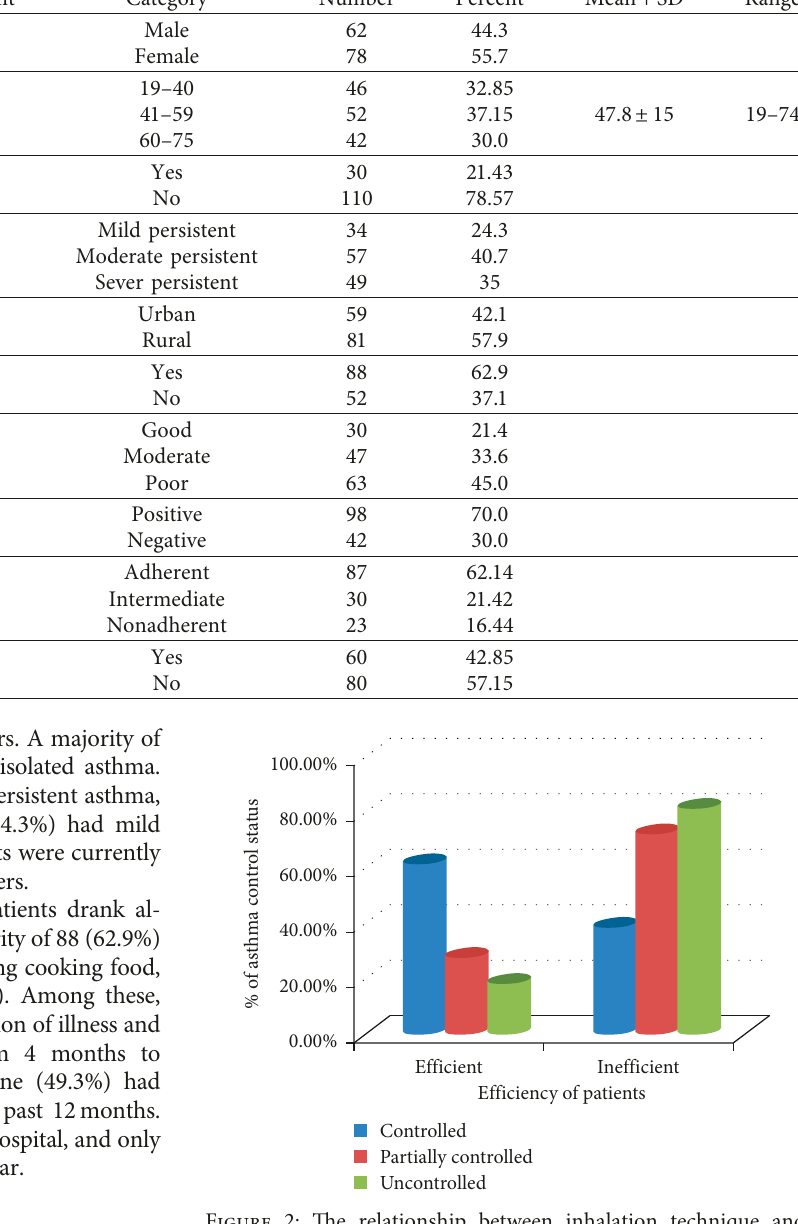
Severity of disease